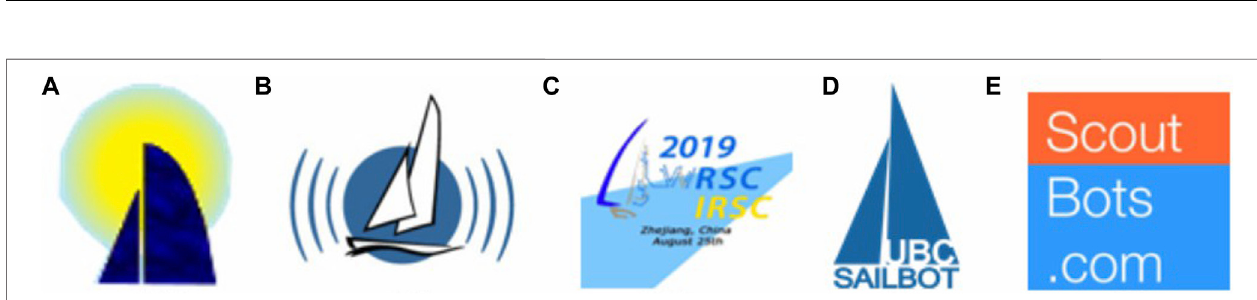
FIGURE3| Sailboatsinexistingsailboatgroupsfromcommercialcompanies. (A) OffshoreSensingAS,Norway. (B) Saildrone,Inc.,USA. (C) OCIUS,Australia. (D) Autonomous Marine System (AMS), USA. (E) Ocean Aero, USA. (F) Everblue, Japan. (G) SubSeaSail, USA.